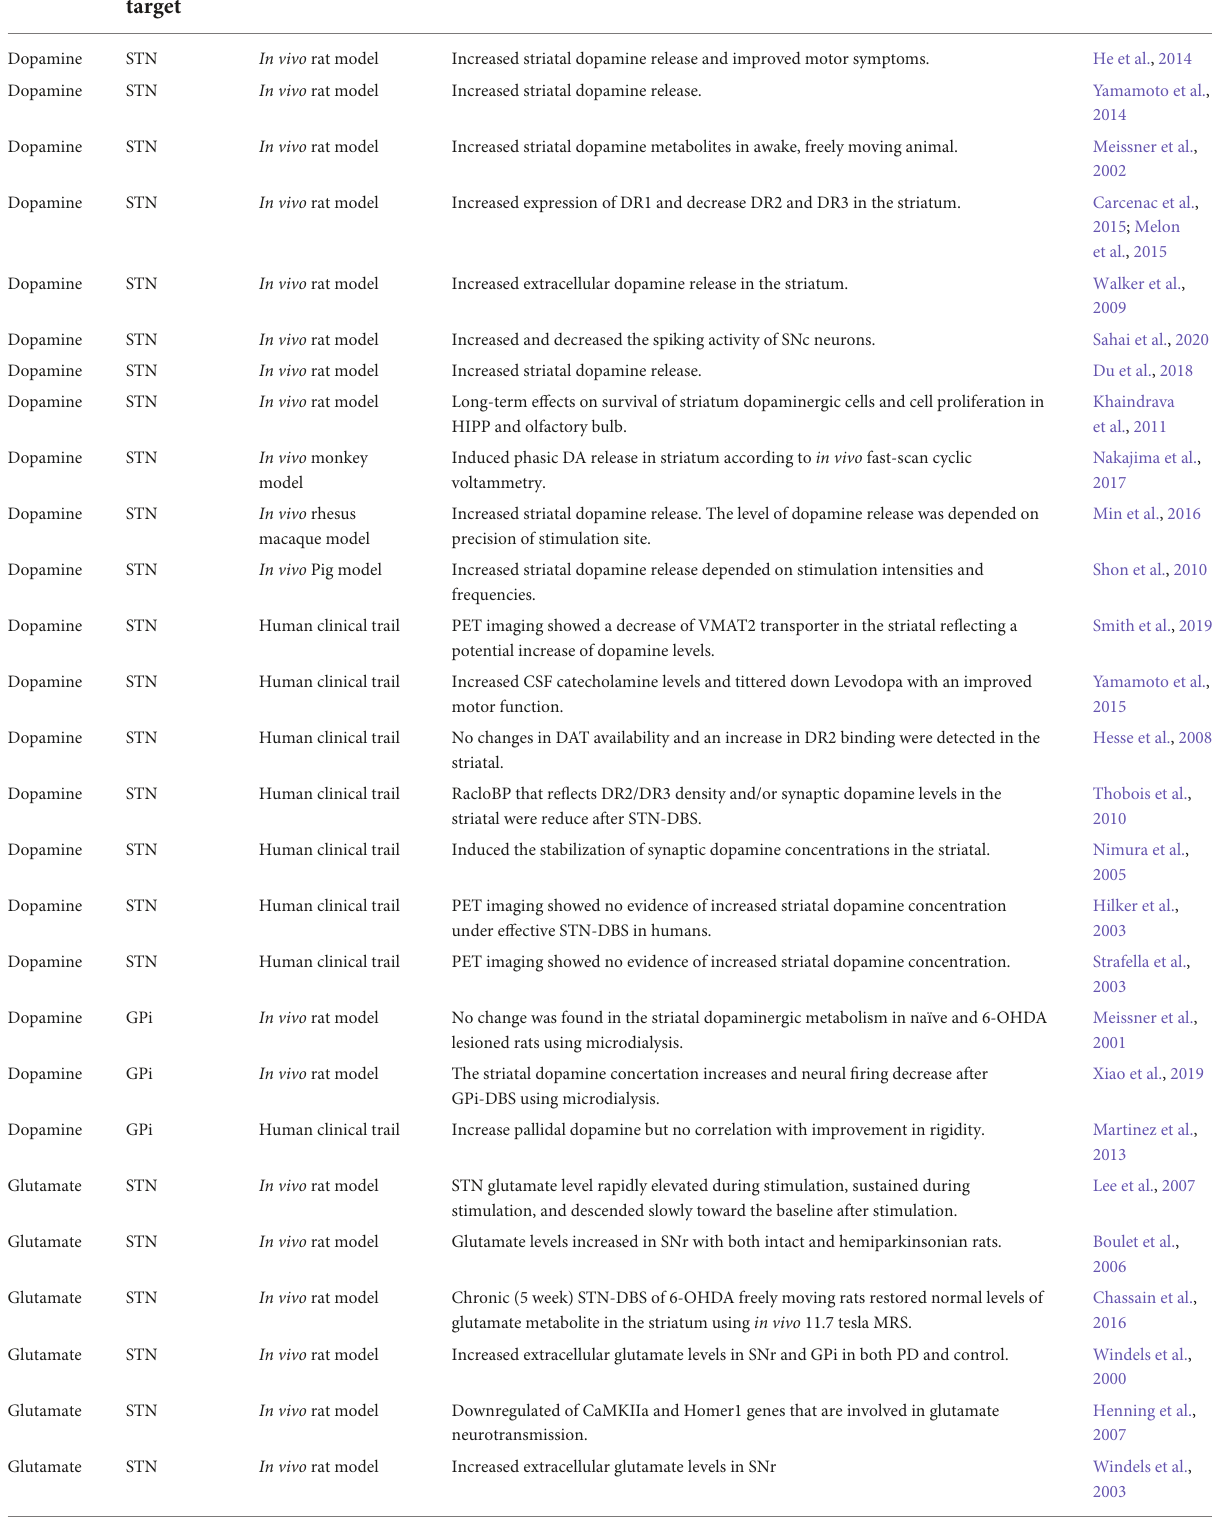
TABLE 1 Neurotransmitters dynamics in response to DBS treatment in